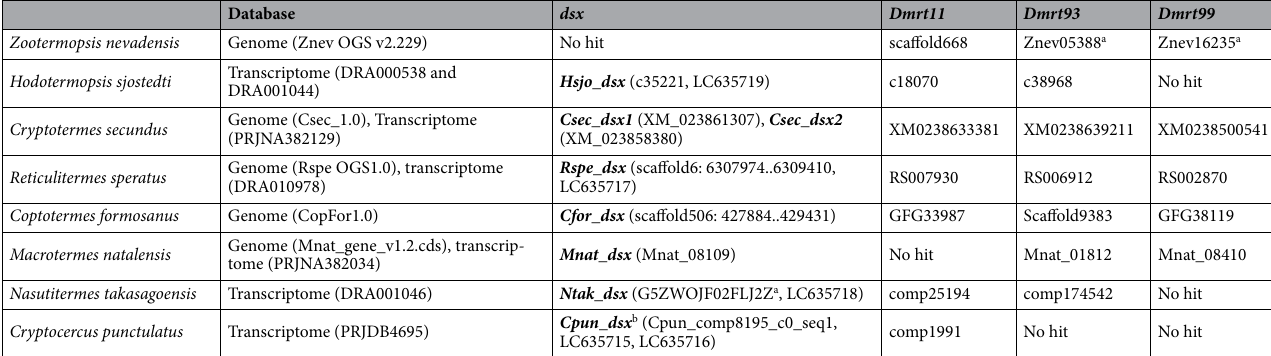
Table 1. Results of BLAST search for OD1 against the genomes and/or transcriptomes of seven termite species and their sister group (subsocial woodroach). Bold italic letters are gene names used in this study. a Previously described by Price et al. 6 . b Found by BLAST search using OD2 (but not OD1) sequences of Blattella dsx orthologues, followed by 5 ′